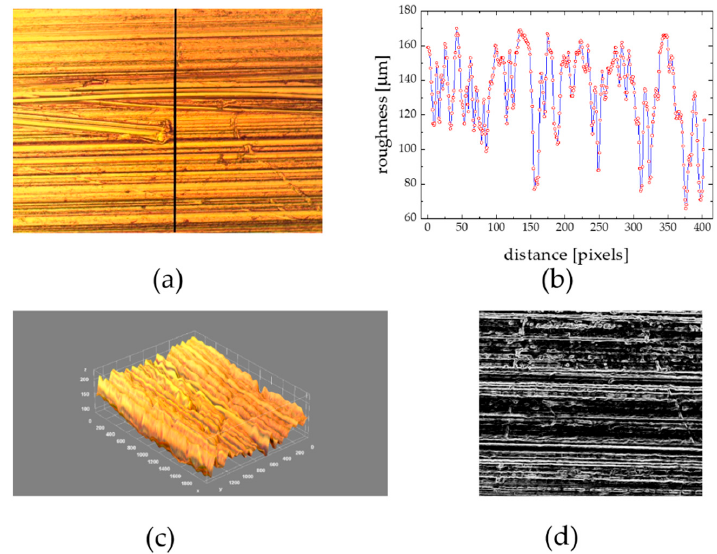
Figure 5. ( a ): A microscopic image of Al surface roughened with a sandpaper (grade 400), ( b ): rough- ness height profile along the line from ( a ), ( c ): 3D surface morphology from ( a ) derived with ImageJ routine, ( d ): ( a ) processed with “find edges” procedure; covered area x = 560 and y = 460 µ m. Dis- tance scale 180 pixels = 50 μ m; R rms roughness = 1.73 ± 0.43 μ m; roughness fluctuation coefficient η = 0.178 ± 0.016.